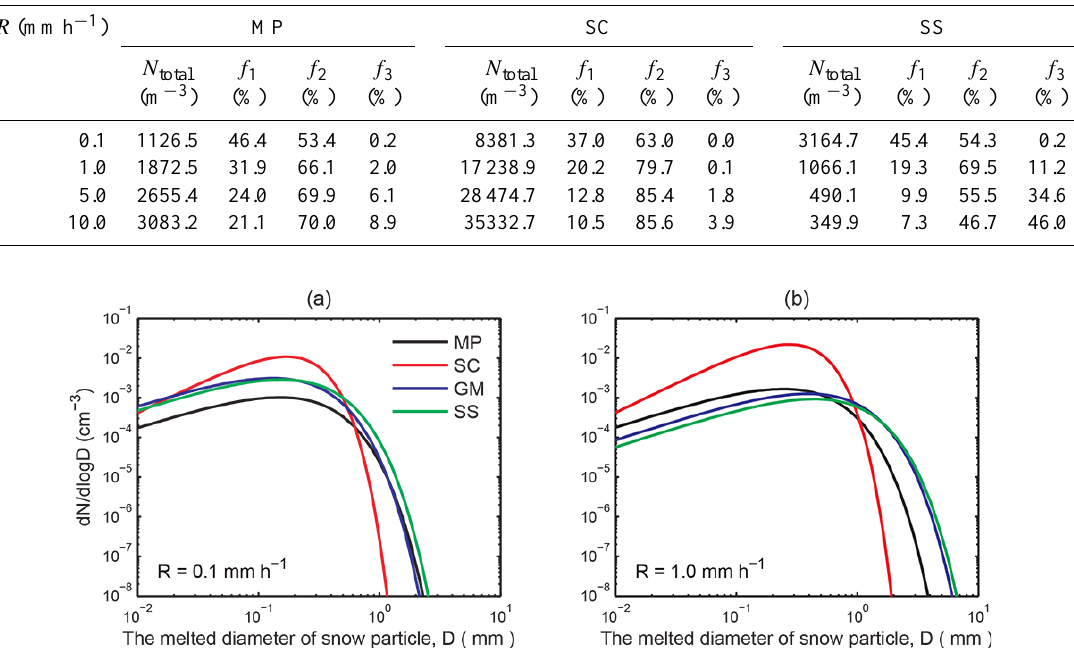
Fig. 3. Snow-particle number size distributions under snowfall intensities (as liquid water equivalent) of (a) 0.1mmh − 1 and (b) 1.0mmh − 1 for four different formulas: MP – Marshall and Palmer (1948); SC – Scott (1982); GM – Gunn and Marshall (1958); and SS – Sekhon and Srivastava